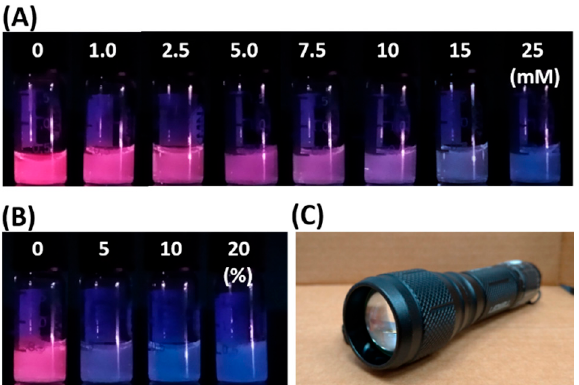
Figure 3. ( A ) PL color images of BSA-Au NCs probe solutions with increasing concentrations of 4- CMC. ( B ) PL images of BSA-Au NCs probe solutions in the presence of 4-CMC (w% from 0% to 20%) at various concentration levels of glucose from 100% to 80%. A smartphone and ( C ) a portable UV-LED lamp were used to capture the PL images.